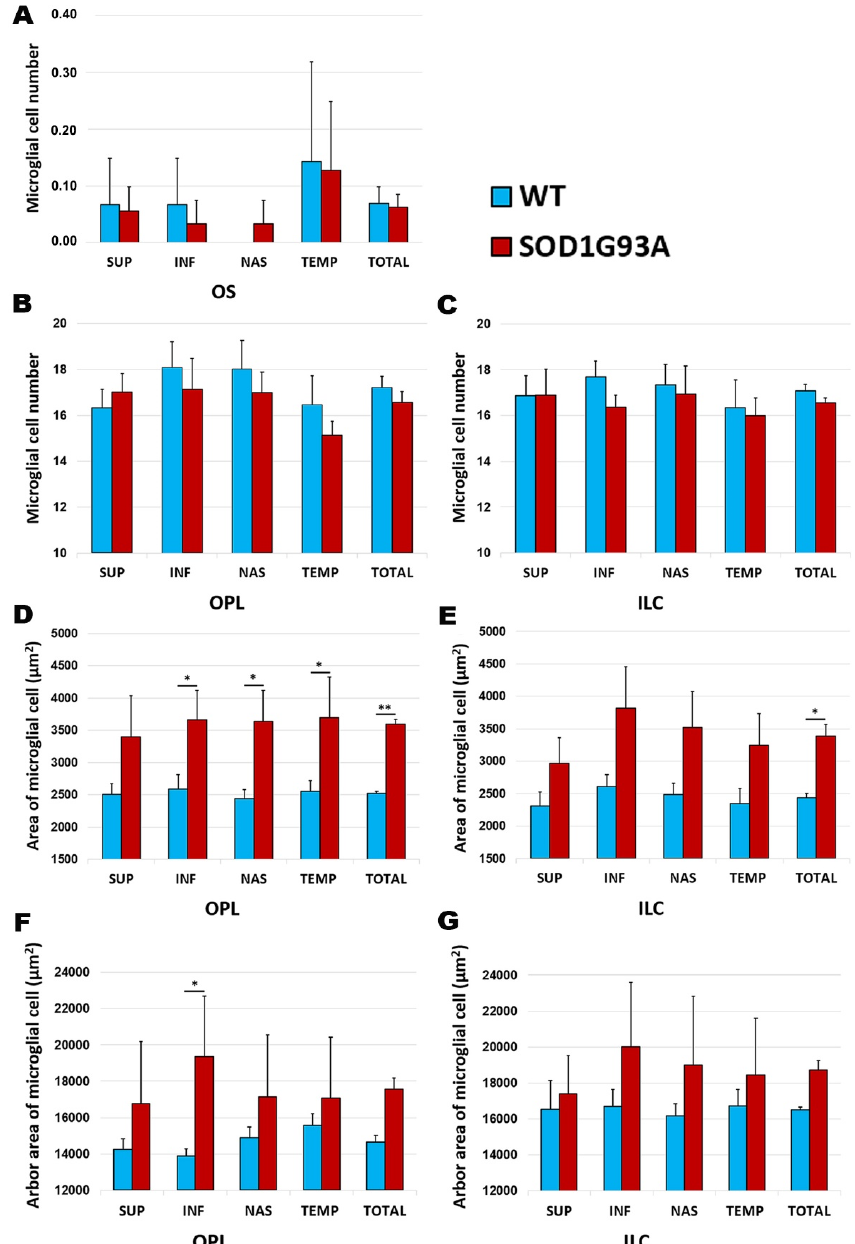
Figure 5. Morphometric analysis of the signs of microglial activation in the wild type group and the SOD1G93A group. ( A – C ) The number of Iba-1+ cells per area of 0.1502 mm 2 in the OS ( A ), OPL ( B ), and ILC ( C ); ( D , E ) Quantitative analysis of the area of the microglial cells ( µ m 2 ) in OPL ( D ) and ILC ( E ). ( F – G ) Quantitative analysis of the arbor area of the microglial cells ( µ m 2 ) in OPL ( F ) and ILC ( G ). The histograms show the mean number ( ± standard deviation, SD). * p < 0.05, ** p < 0.01. Photoreceptor outer segment layer (OS), outer plexiform layer (OPL), and inner layer complex (ILC) (constituted by an inner plexiform layer and a nerve fiber–ganglion cell layer). Wild type (WT). Superior (SUP), inferior (INF), nasal (NAS), and temporal (TEM). Number of retinas used in the experiment, WT: n = 6; and SOD1G93A: n = 6. Statistical test: Mann–Whitney U